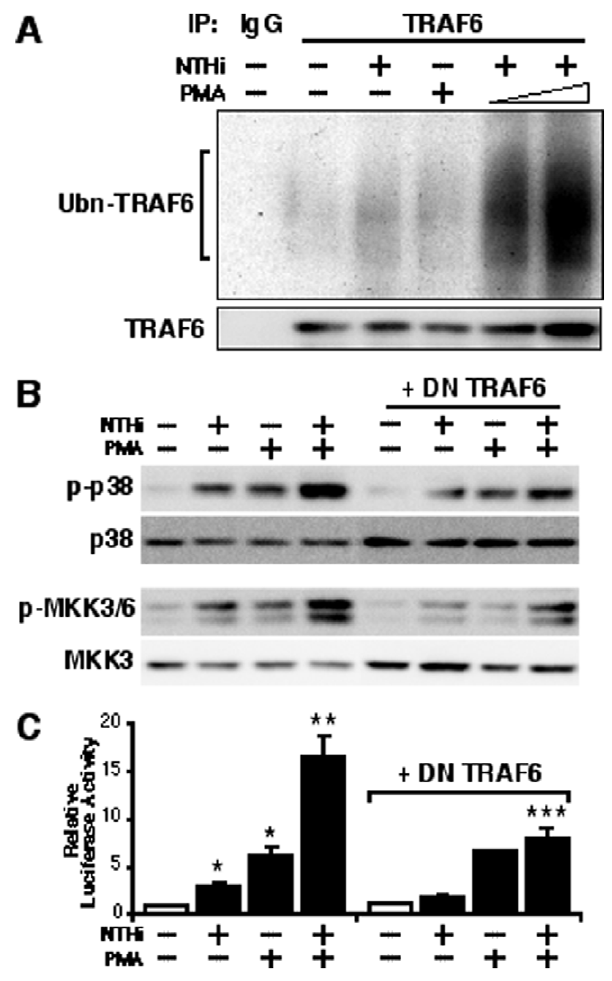
Figure 5. PMA synergistically enhances TLR-dependent MU- C5AC induction by NTHi via TRAF6. ( A ) PMA synergistically enhanced NTHi-induced polyubiquitination of TRAF6 in human epithelial cells. Cells were transfected with TRAF6, and were treated with NTHi and PMA as indicated. Whole cell extracts were subjected to co-immunoprecipitation (IP) with either control IgG or anti-TRAF6 antibodies and immunoblotting with anti-ubiquitin antibody. The same blots were re-probed with anti-TRAF6. ( B ) Overexpression of a DN mutant form of TRAF6 blocked the synergistic phosphorylation of p38 MAPK and MKK3/6 induced by NTHi and PMA. Cells were transfected with 0.8 m g of DN-TRAF6 or control vector, and treated with NTHi with or without PMA. Cell lysate was blotted with antibodies as indicated in the figure. ( C ) The synergistic enhancement of NTHi-induced MUC5AC transcription by PMA was inhibited by overexpression of DN-TRAF6 in human epithelial cells, as assessed by MUC5AC-dependent promoter Luciferase assay. Cells were transfected with 0.8 m g of DN-TRAF6 or control vector, and treated with NTHi with or without PMA. Relative luciferase activity of MUC5AC was measured from the cell lysate. Values are the means 6 S.D. (n=3). *p , 0.05 vs. control; **p , 0.05 vs. NTHi alone; *** p , 0.05 vs. NTHi with PMA in control vector transfected cells. The data shown are representative of three independent experiments. 2 , absence of; + , presence of; NTHi, nontypeable Haemophilus influenzae ; DN, dominant negative; Ubn, ubiquitin.